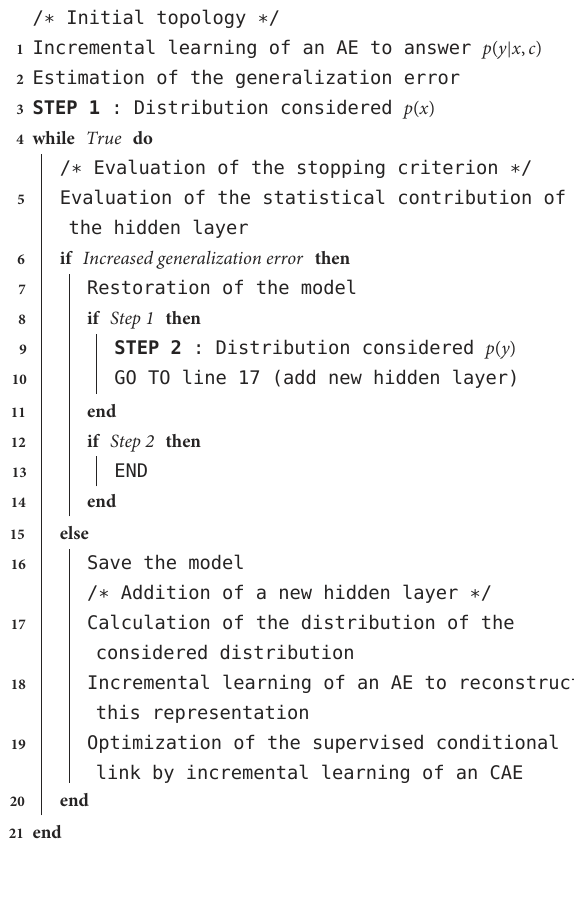
Algorithm 3. Conditional incremental optimization.